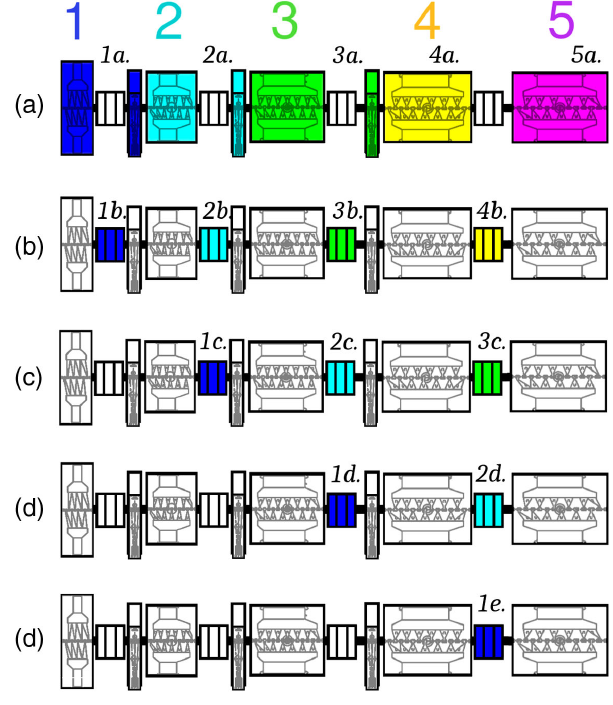
FIG. 10. Graphical representation of tuning sequences from Table III for various ISAC-DTL configurations, corresponding to Tank 1 to 5 E=A cases (Table I). Colors represent optimization at a given energy, e.g., dark blue is up to 0.254 MeV/u. The optimizer is called upon in the sequence a to e , 1 to 5. Step a corresponds to longitudinal tank configuration, while steps f b; c; d; e g accomplish DTL triplet tuning, in each case using TRANSOPTR ’ s optimizer. Tanks 1 to 3 are optimized with their